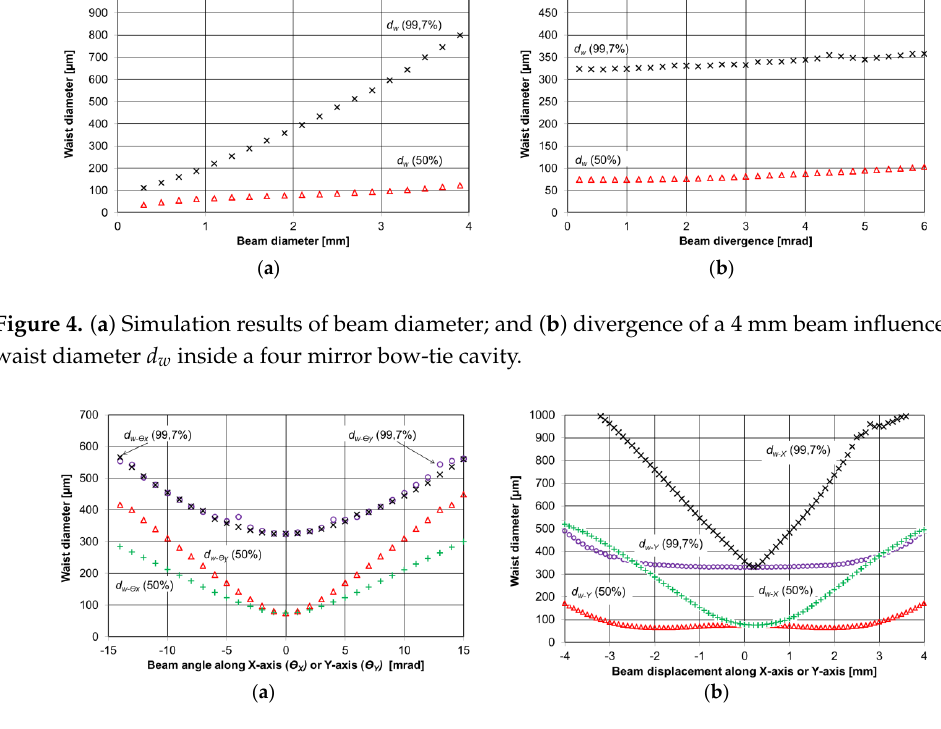
Figure 5. ( a ) Results of simulation of the QCL 4 mm beam waist diameter ( d w ) inside the cavity versus the QCL beam angle; and ( b ) the beam displacement.